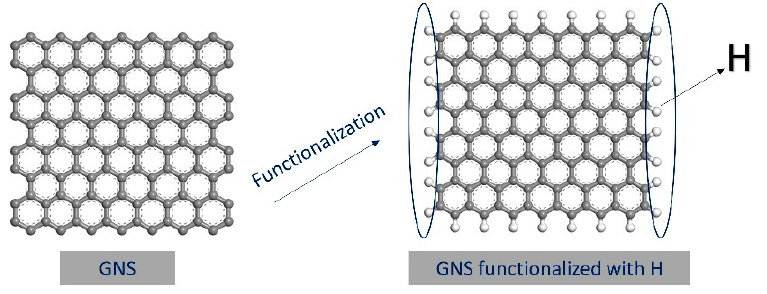
Figure 1. Graphene functionalized with hydrogen atoms.